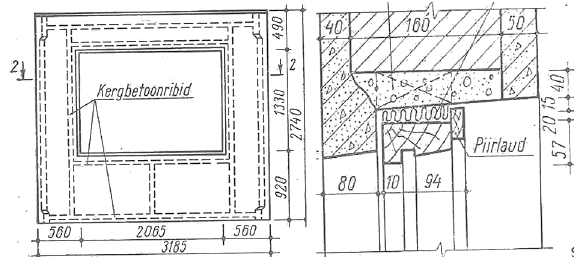
Fig. 3. Original design drawings of reinforced concrete large- panel element building – external wall element (left) and external wall/ window junction (right)